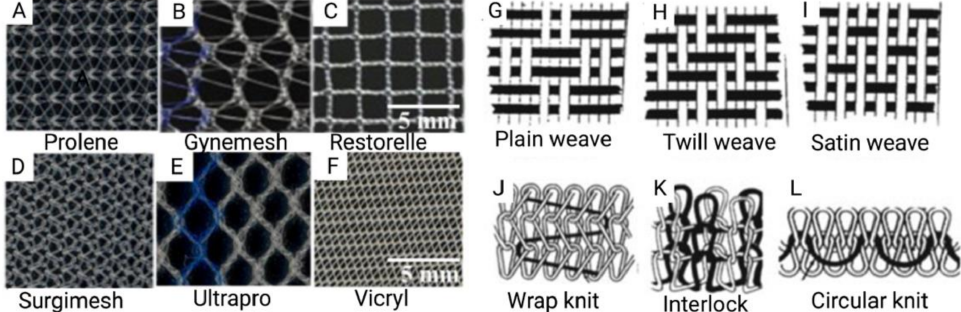
Figure 2. ( A – F ) Commercially available prosthetic meshes for POP; ( G – L ) Illustrations of mesh topography demonstrating different weave and knit types. Reprinted from Pott et al. (2012)